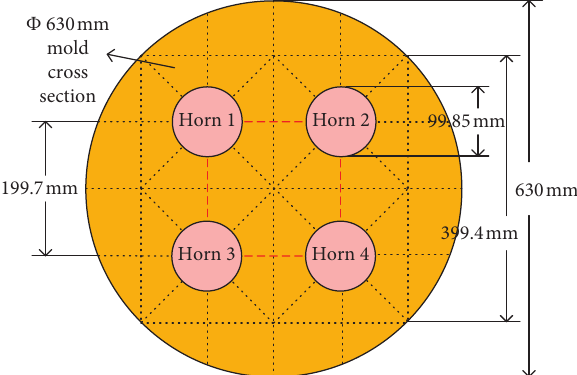
Figure 10: Experimental device of traditional ultrasonic-assisted casting.